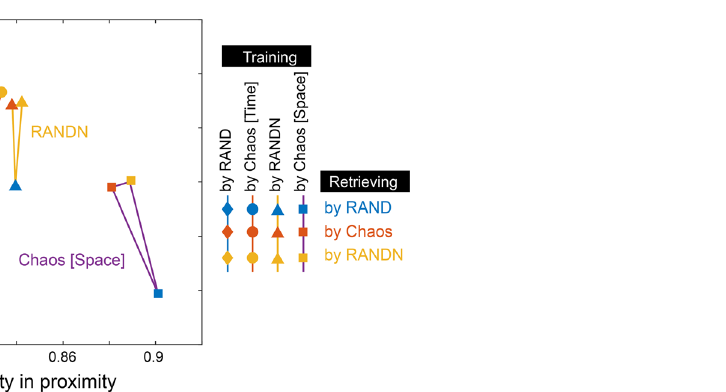
In Fig. 5, the random sequences used for training are represented by different shapes of marks: diamonds for uniformly distributed pseudorandom numbers (RAND), circles for time-domain chaos (SI: 50 ps), triangles for nonuniformly distributed pseudorandom numbers (RANDN σ = 0.2), and squares for space-domain chaos (SI: